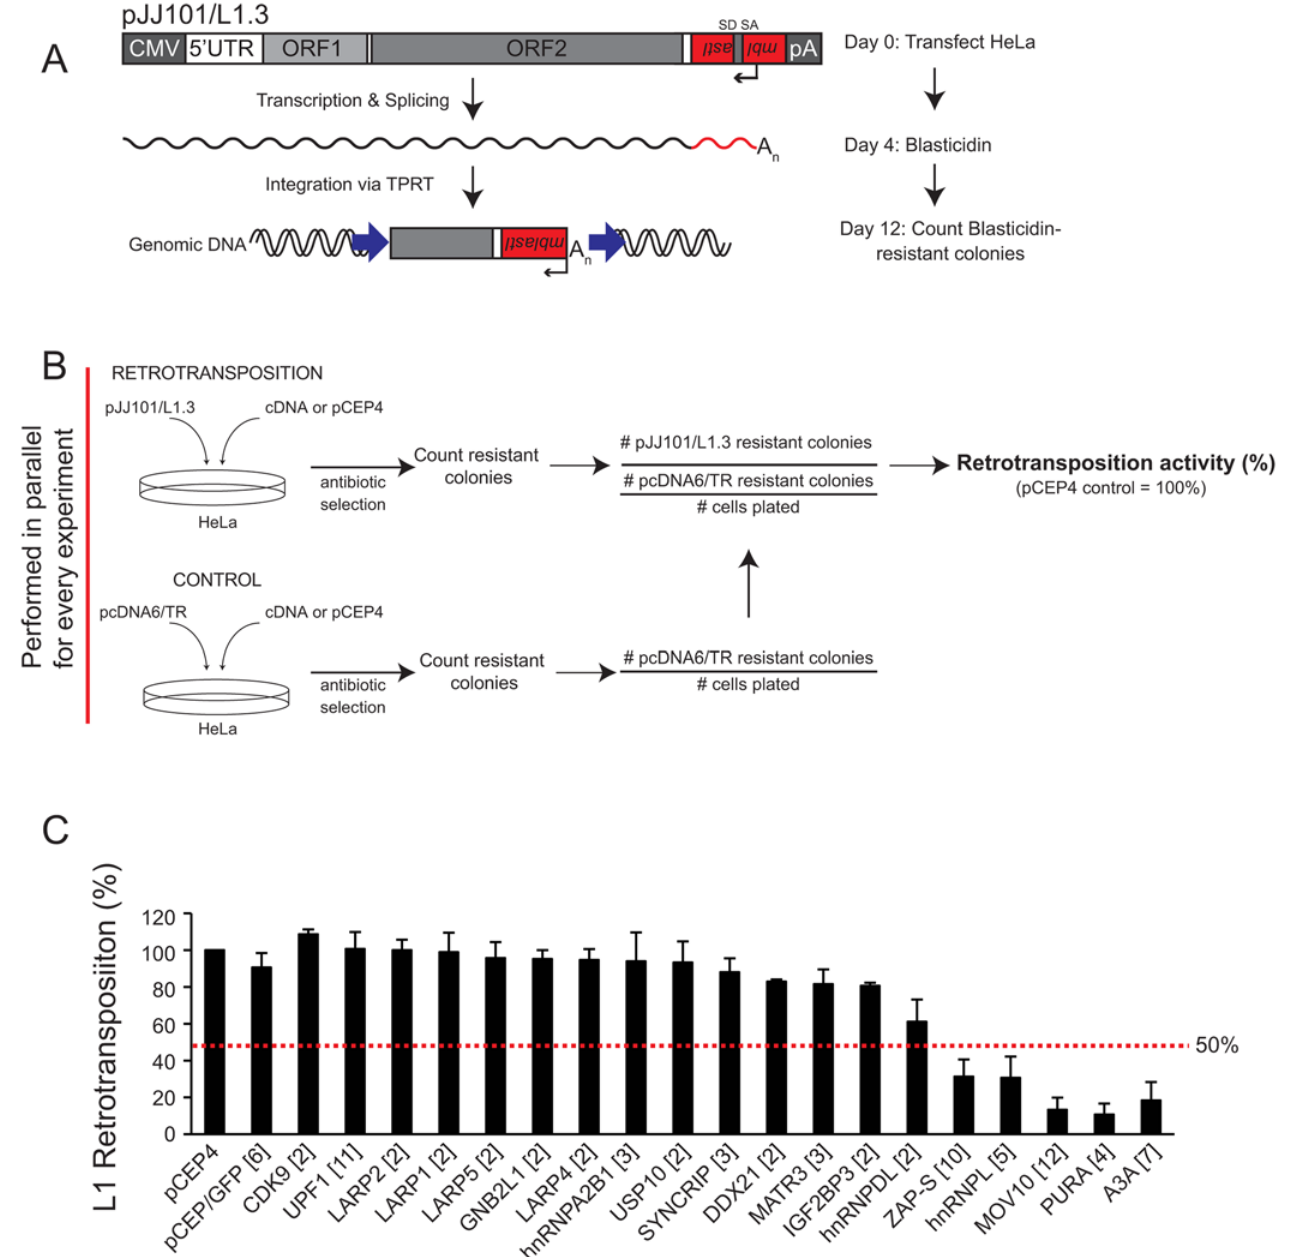
Fig 2. Several of the ORF1p-FLAG interacting proteins inhibit L1 retrotransposition. (A) Schematic of the cultured-cell retrotransposition assay : HeLa cells were transfected with an engineered human L1.3 construct (pJJ101/L1.3) marked with a blasticidin indicator cassette ( mblastI ). The pJJ101/L1.3 construct was cloned into a pCEP4 mammalian expression vector. A CMV promoter augments L1 expression and an SV40 polyadenylation signal (pA) is located downstream of the native L1 polyadenylation signal. The mblastI cassette is cloned into the L1 3' UTR antisense to the L1 and contains a blasticidin deaminase gene that is disrupted by an intron in the L1 sense orientation. The blasticidin deaminase gene can only be expressed when the L1 transcript is spliced, reverse transcribed, and inserted into genomic DNA [30,71]. (B) Schematic of the pJJ101/L1 . 3 retrotransposition screen : To analyze the effect of the ORF1p-FLAG interacting proteins on L1 retrotransposition, HeLa cells were co-transfected with equal amounts of pJJ101/L1.3 and a cDNA plasmid expressing one of the candidate ORF1p-FLAG interacting proteins or a pCEP4 empty vector. To control for potential off-target effects, HeLa cells also were co-transfected with a control plasmid (pcDNA6/TR) that expresses the blasticidin deaminase gene and a cDNA plasmid expressing one of the candidate proteins or a pCEP4 empty vector. Both assays were subjected to the same blasticidin selection regimen. The resultant number of blasticidin-resistant colonies in pcDNA6/TR control assays provides a visual, quantitative readout of the effect of cDNA overexpression on the ability of cells to grow in the presence of blasticidin. (C) Results of pJJ101/L1 . 3 retrotransposition screen : HeLa cells were co-transfected with pJJ101/L1.3 and each of the indicated cDNA expressing plasmids. L1 retrotransposition was assayed in 6-well tissue culture plates. The X-axis indicates the cDNA that was co-transfected